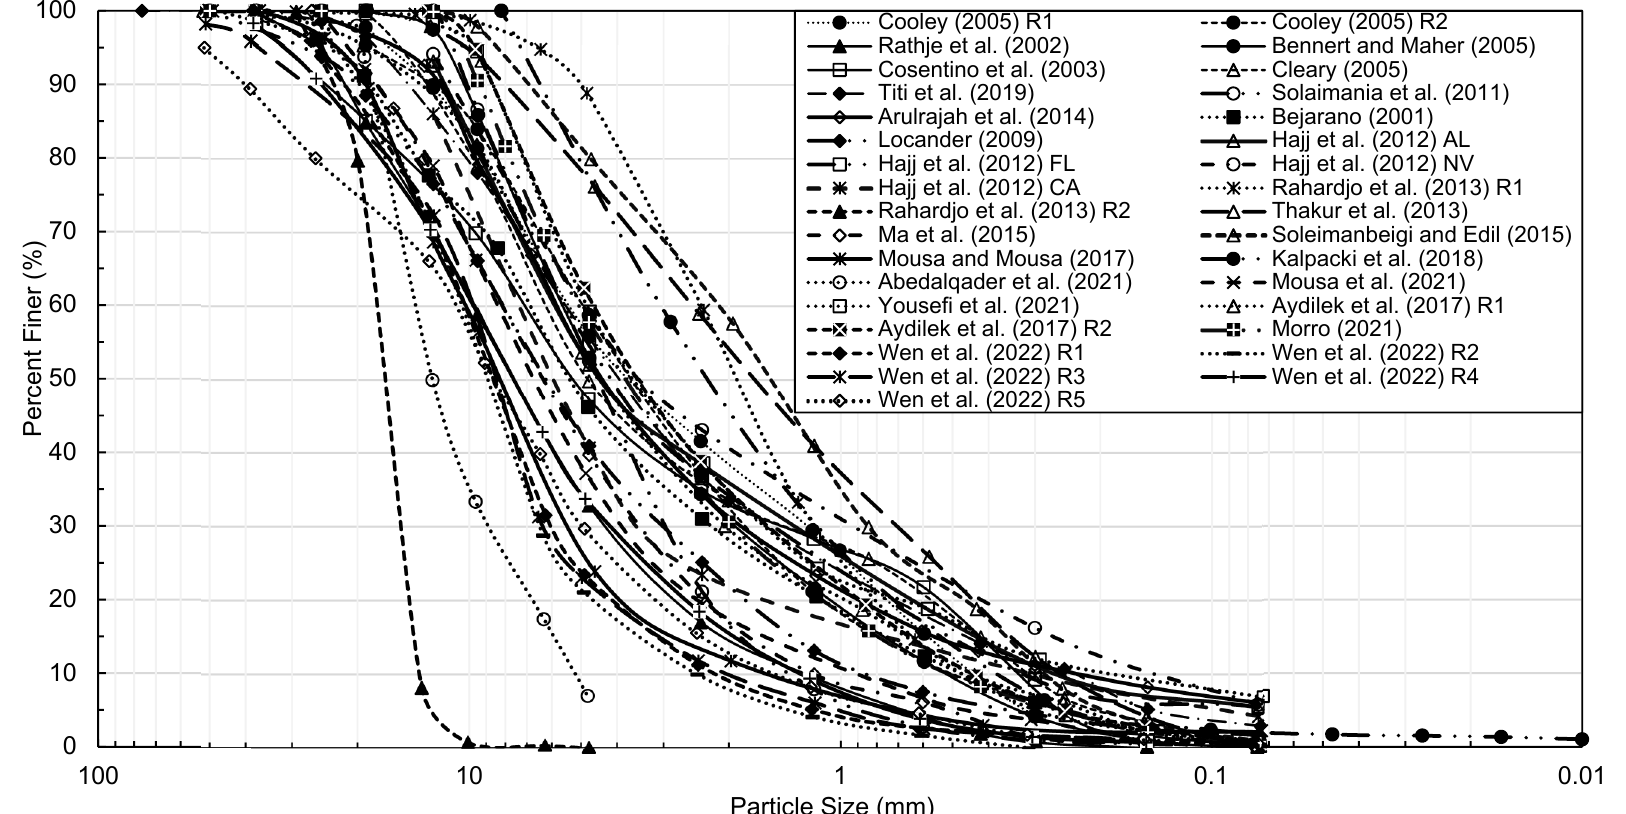
Figure 3. Gradation curves for RAP reported in the literature [12,15–19,22,24,26,30–36,38,44,46,51,52].